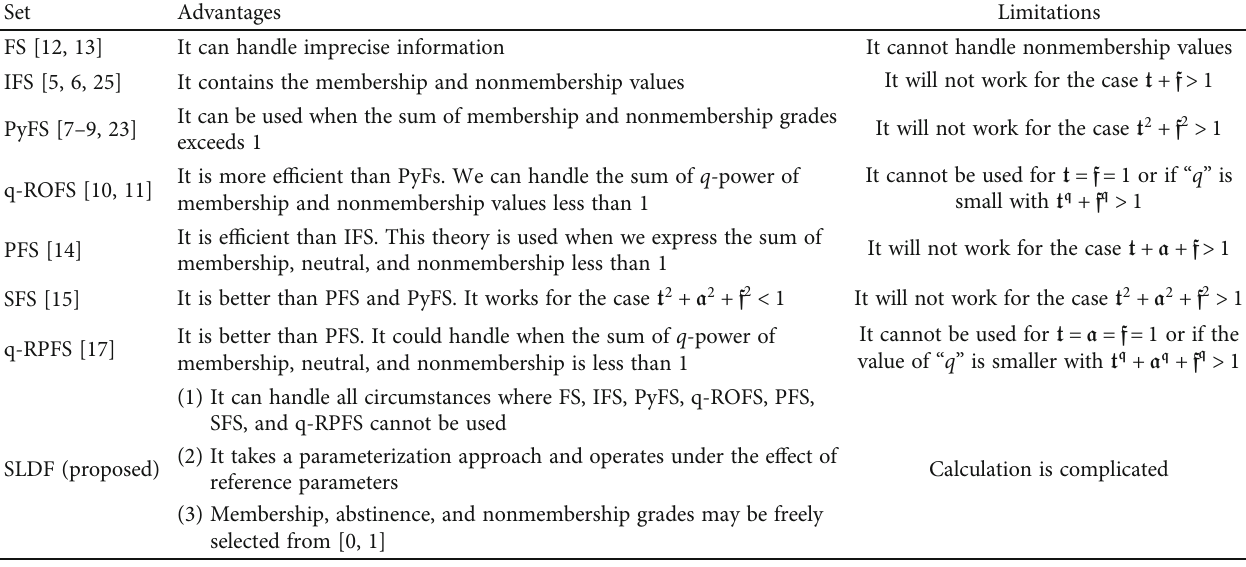
Table 11: Comparison between some existing sets and SLDFS.